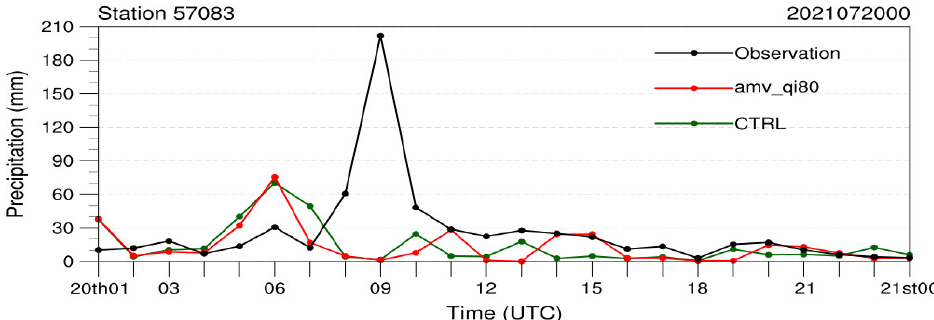
Figure 12. Variation of hourly precipitation on 20 July 2021 from the observations, the CTRL and the amv_qi80 at the location of station 57083 (34.72°N, 113.65°E), which recorded the maximum rainfall in the Henan 7.20 rainstorm.